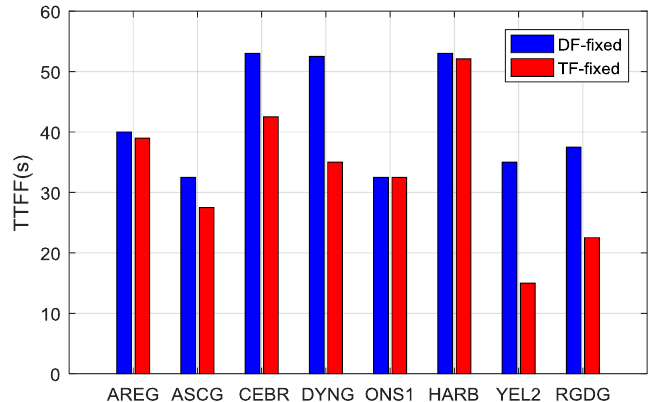
Figure 10. Average TTFF of the 288-LEO augmented GNSS PPP AR at dual-frequency and triple-frequency modes.